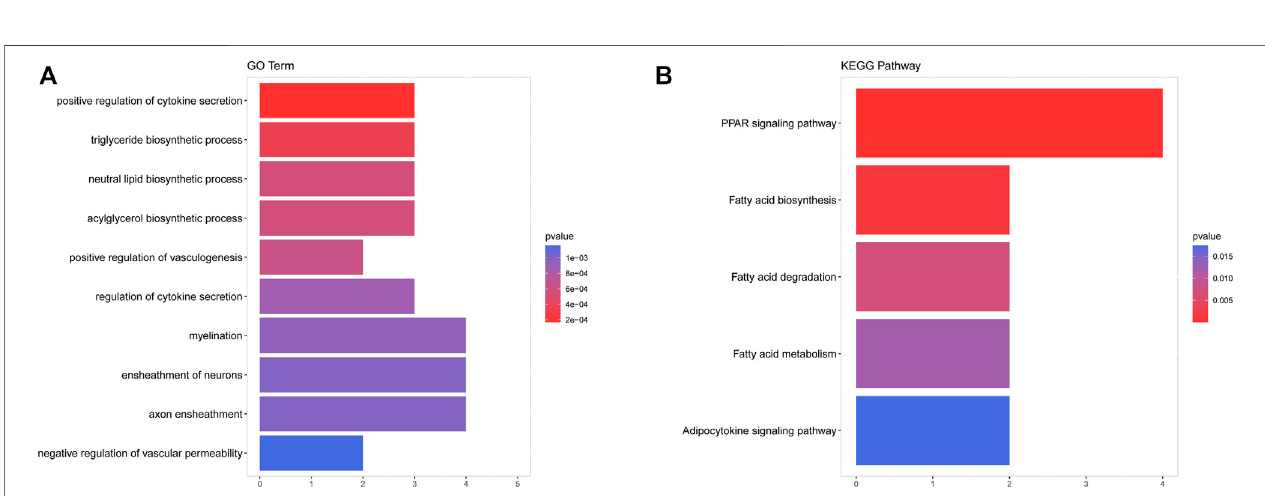
FIGURE4| FunctionalenrichmentofanalysisofDE-mRNAsbasedonGOandKEGG. (A) Thetop10termsintheGO-BPcategoryofGOanalysesDE-mRNAs. (B) KEGG pathway analysis of DE-mRNAs.